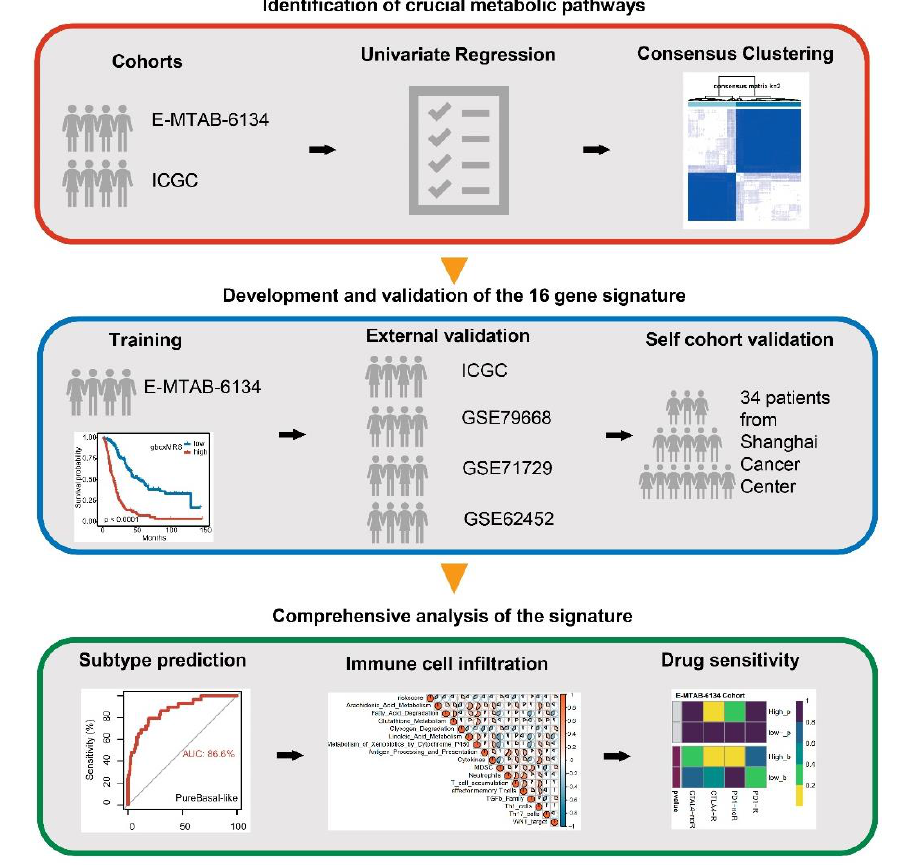
Figure 1. Workflow of the study.